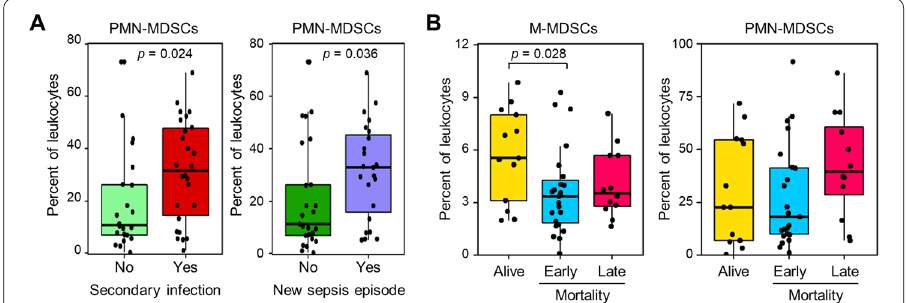
Fig. 3 A PMN‑MDSCs in relation with secondary infection and new sepsis episode. B M‑MDSCs and PMN‑MDCs in survivors ( n 14), early deaths ( 28 days, n 23) and late deaths (> 28 days, n = ≤ = show median, upper and lower quartiles. Whiskers show 5 to 95 percentiles. Each dot represents an individual